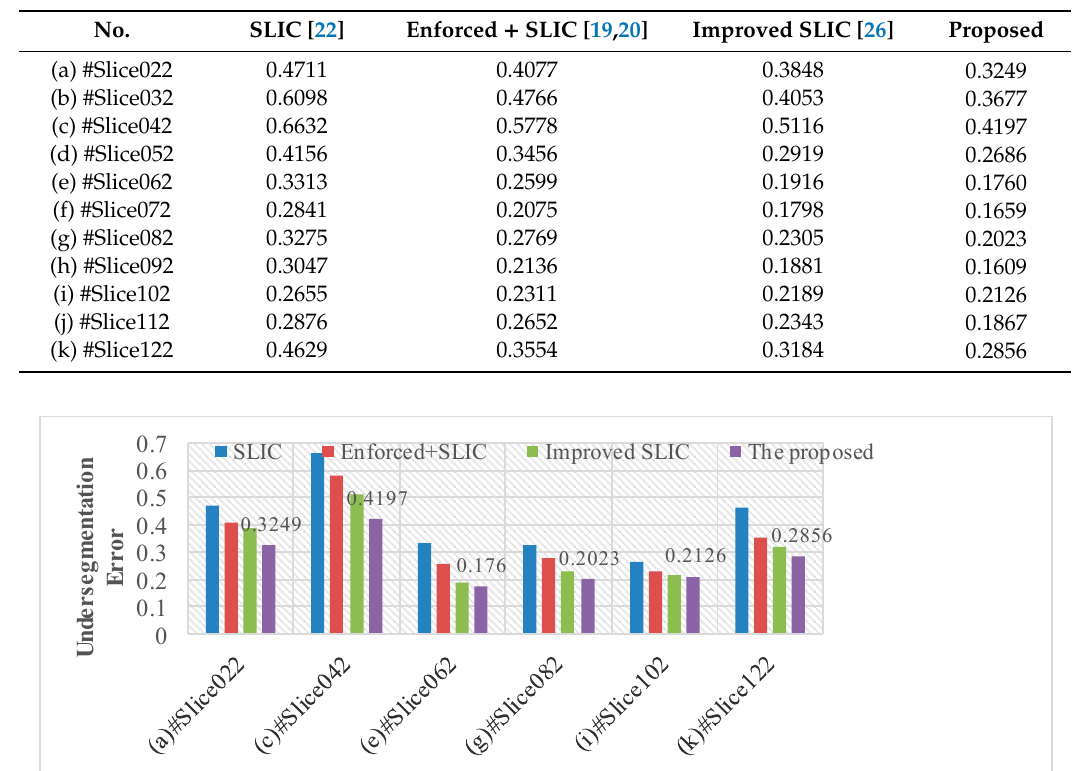
Figure 6. The Undersegmentation error of different algorithms on selected slices. Table 1. The comparison of UE of different algorithms.